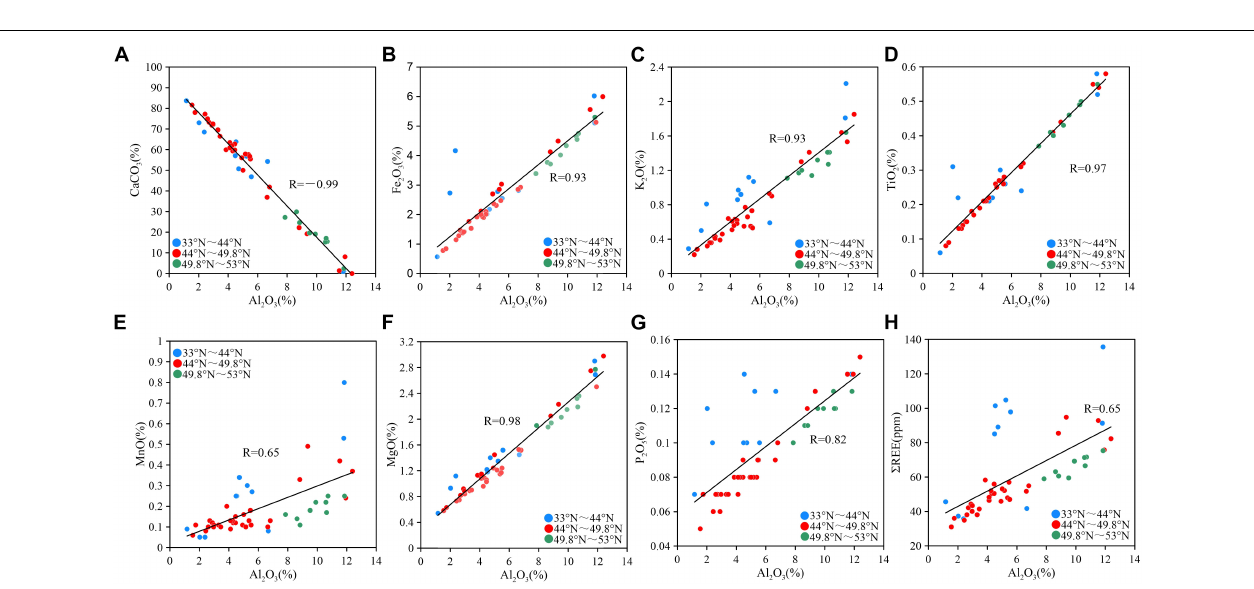
FIGURE 5 | The scatter plots between grain size and contents of major elements. The correlation between water depth and grain size ( R = − 0.74, A ), the correlation between Al 2 O 3 and grain size ( R = − 0.71, B ), the correlation between MnO and grain size ( R = − 0.67, C ), the correlation between TiO 2 and grain size ( R = − 0.69, D ), the correlation between TOC and grain size ( R = 0.15, E ) and the correlation between (cid:54) REE and grain size ( R = − 0.79, F ).